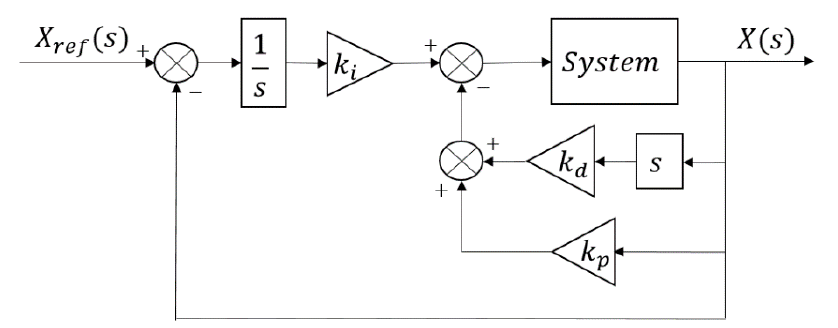
Figure 3. Block diagram of the I-PD controller.